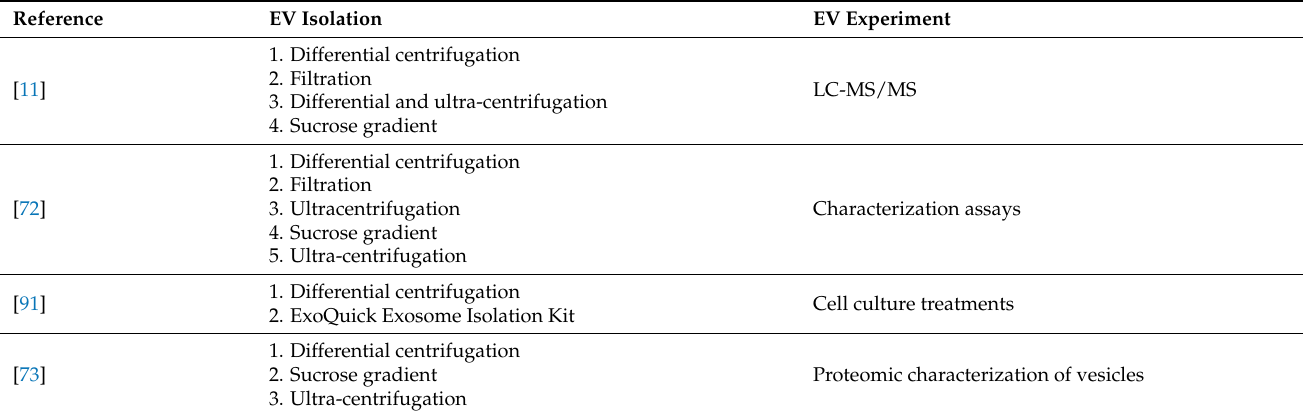
Table 1. Summary of experimental approaches for small extracellular vesicle (EV) isolation from human milk.